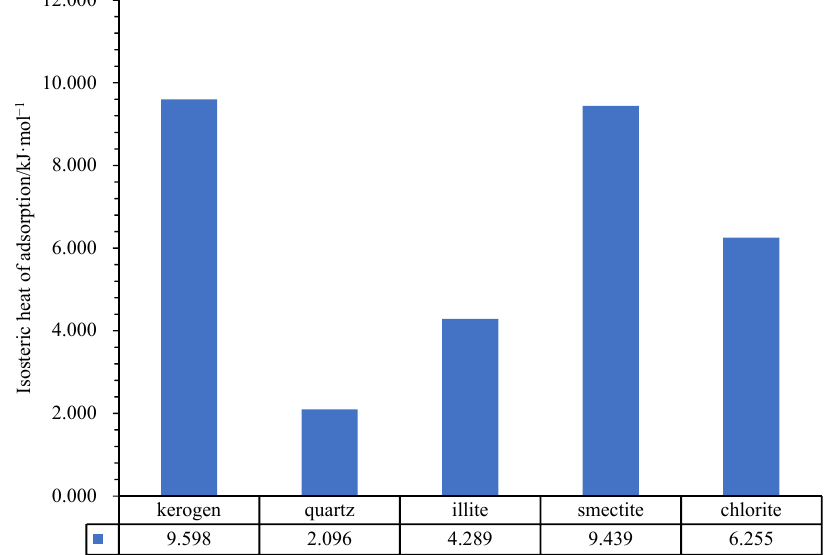
Figure 7. Isosteric heat of adsorption of different minerals.